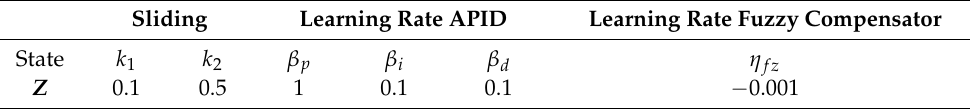
Table 3. APID and fuzzy compensator gains parameters.